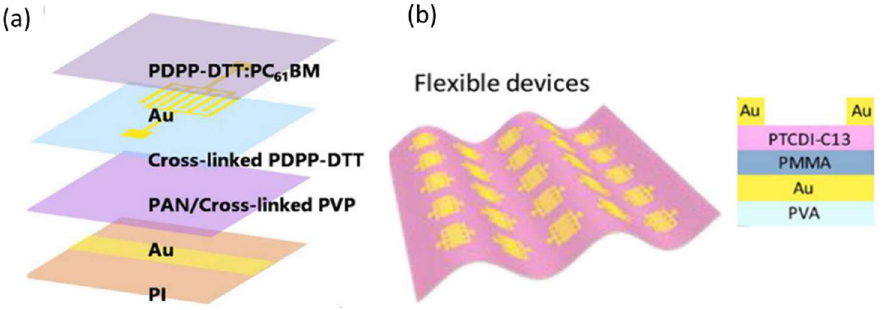
Figure 4. ( a ) Schematics of the flexible OPT reprinted with permission from [44] ©2020 Elsevier . and ( b ) the conformal device reprinted with permission from [104] ©2018 Nature Portfolio. ( b ) the conformal device reprinted with permission from [104] ©2018 Nature